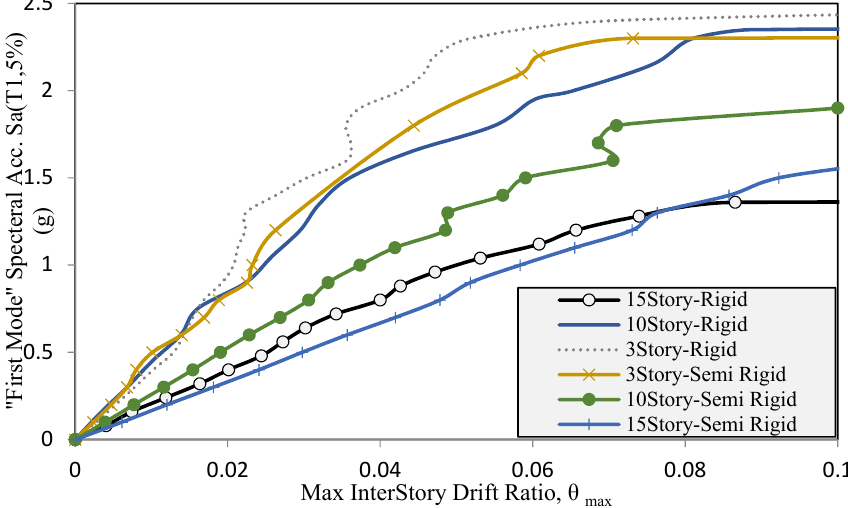
Figure 21. Comparison of 50% curves for IDA curves obtained for all cases.